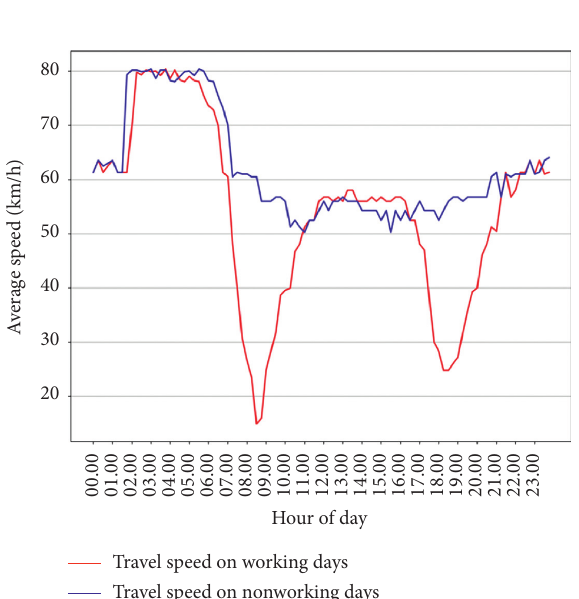
Figure 14: Travel speed of the experimental road section.